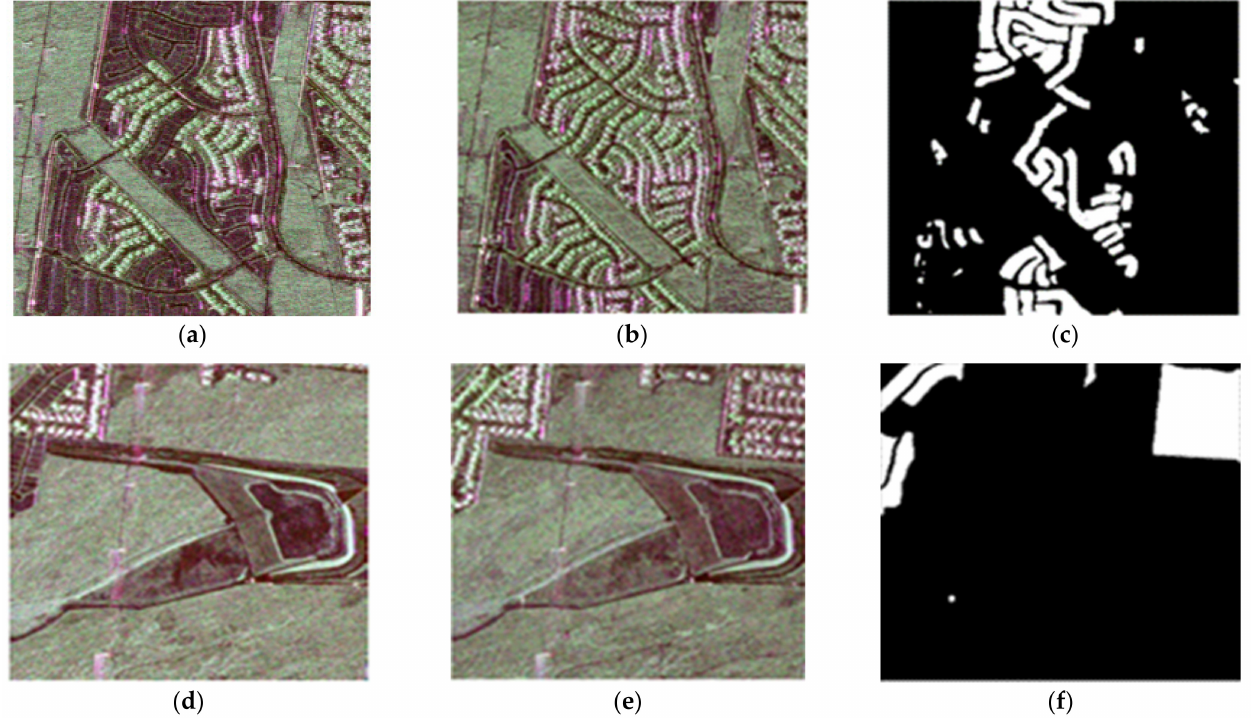
Figure 6. Pauli decomposition of UAVSAR images taken over Los Angeles, California on ( a , d ) 23 April 2009; ( b , e ) 11 May 2015; ( c , f ) ground truths, where white means change area and black means no-change area. Top: dataset#1. Bottom: